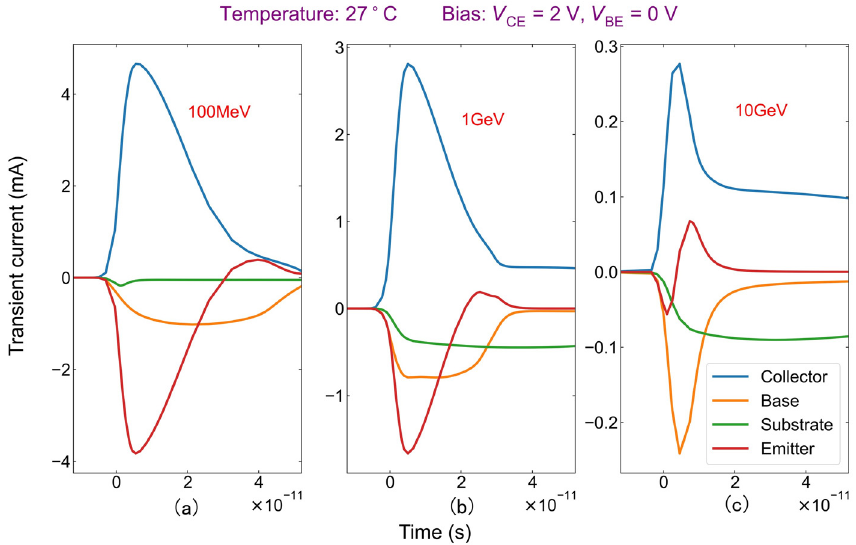
Figure 10. The transient waveforms of the TCAD simulation produced by incident Fe ions of different energies ( a ) 100 MeV, ( b ) 1 GeV and ( c ) 10 GeV at room temperature.